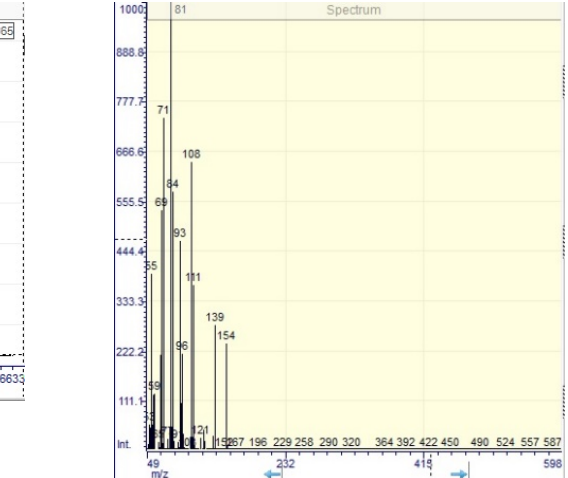
Figure 1. Left —GC chromatogram of Rosmarinus officinalis tincture. Right —MS spectra of separated Figure 1. Left - GC chromatogram of Rosmarinus officinalis tincture. Right -MS spectra of separated 1,8-cineole.